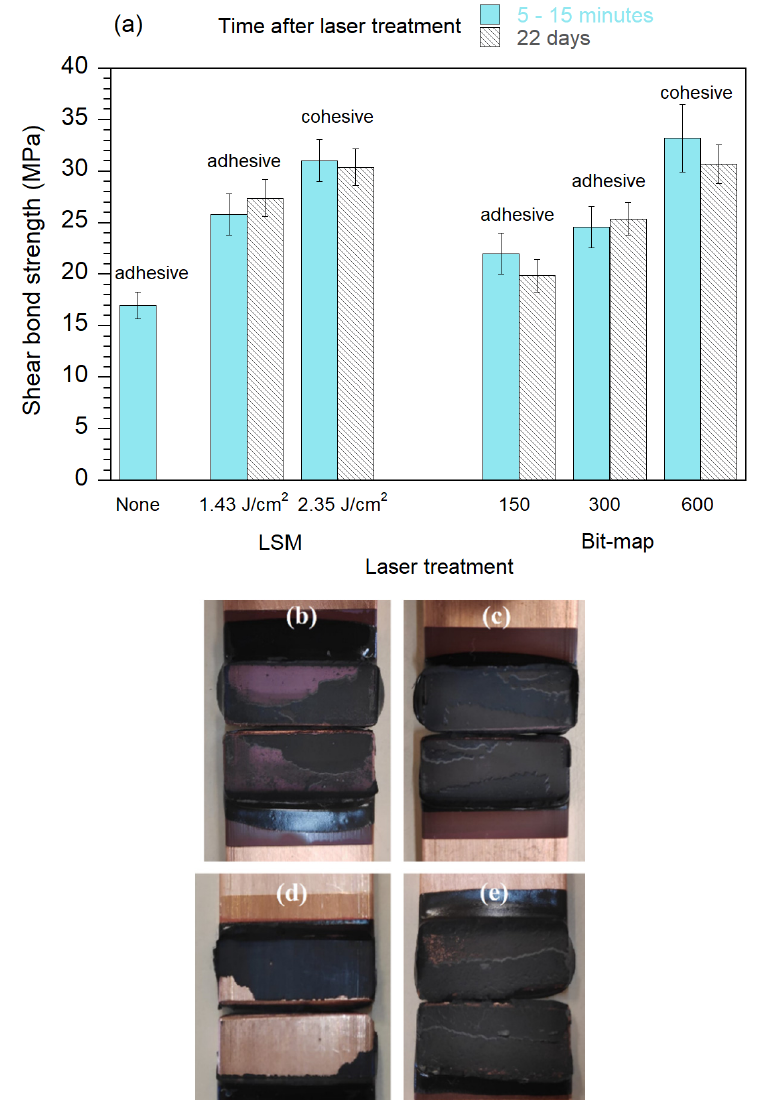
Figure 7. ( a ) Shear bond strength values for different joints after laser processing the copper surfaces in air using LSM or bit-map at different F p or pixels, respectively. The value for the joint prepared with non-irradiated polished Cu is also included. The type of bond failure for each case is indicated. Pictures of some of the joints after testing: ( b ) LSM 1.43 J/cm 2 , ( c ) LSM 2.35 J/cm 2 , ( d ) bit-map 150, and ( e ) bit-map 600.